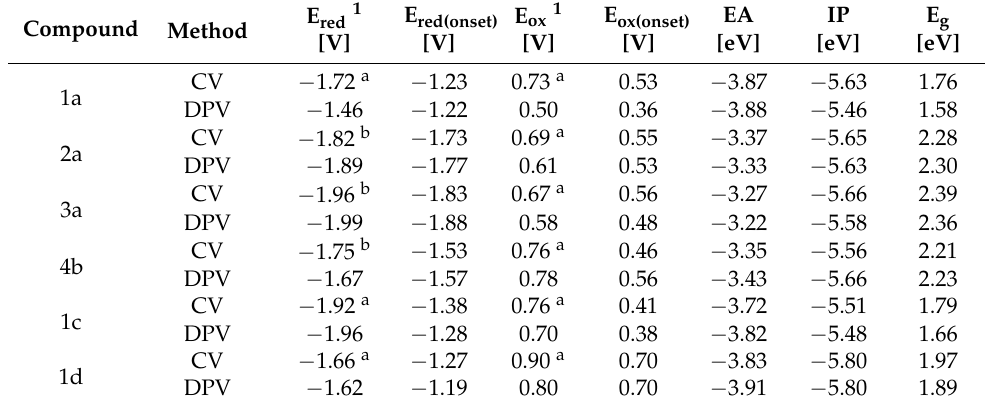
Table 3. Electrochemical data of the bis-(imino-1,8-naphthalimide) derivatives.